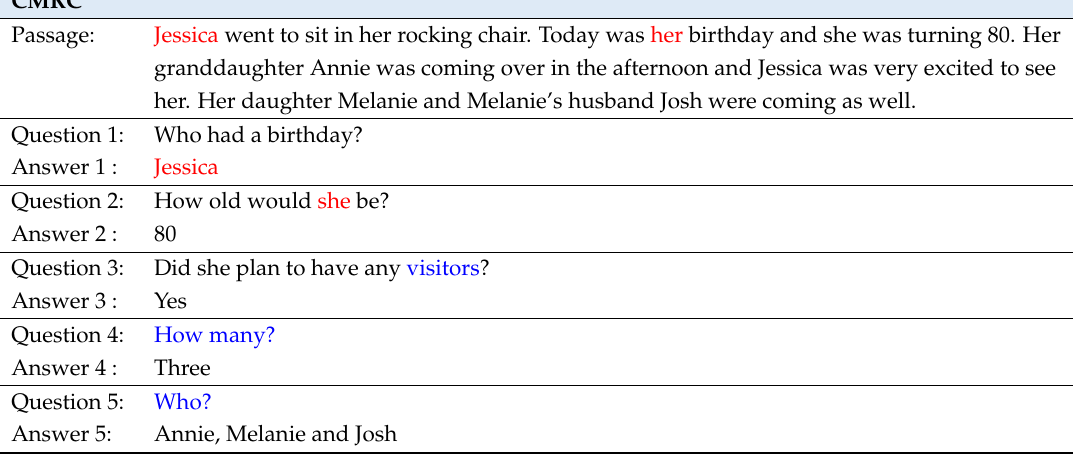
Table 15. An example of the CoQA